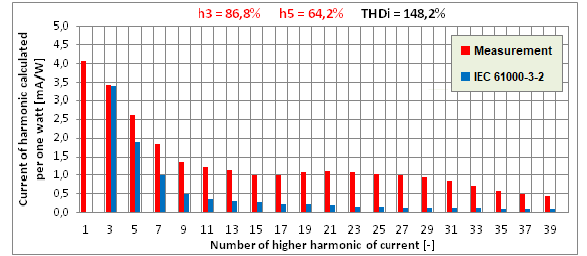
Fig. 1. Harmonic spectrum of current in 12 W LED lamp .